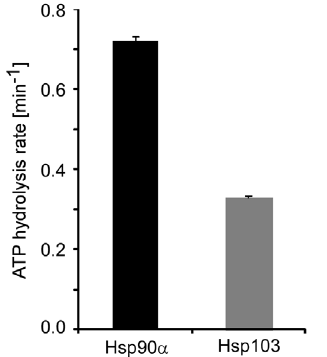
Figure 4. The E domain acts as a negative regulator of Hsp103 9 s intrinsic ATPase activity. The ATP hydrolysis rates of human Hsp90 a and Hsp103 with the extra domain was measured. Three independent experiments were averaged and the standard deviation depicted by error bars.